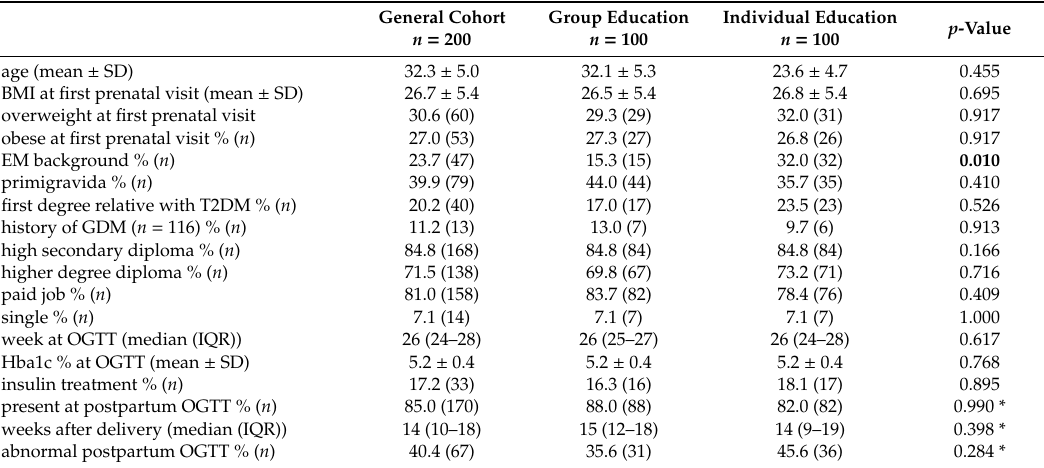
Table 2. Baseline characteristics.